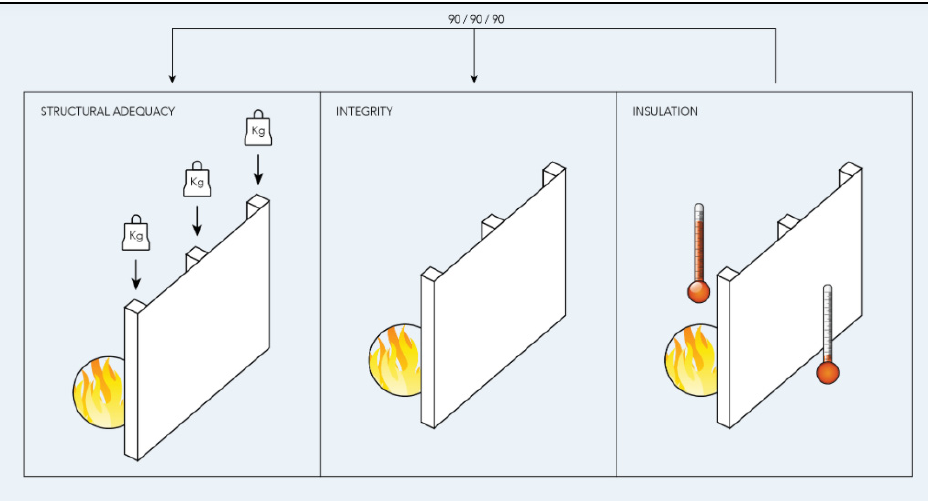
Figure 10. Fire ‐ resistance